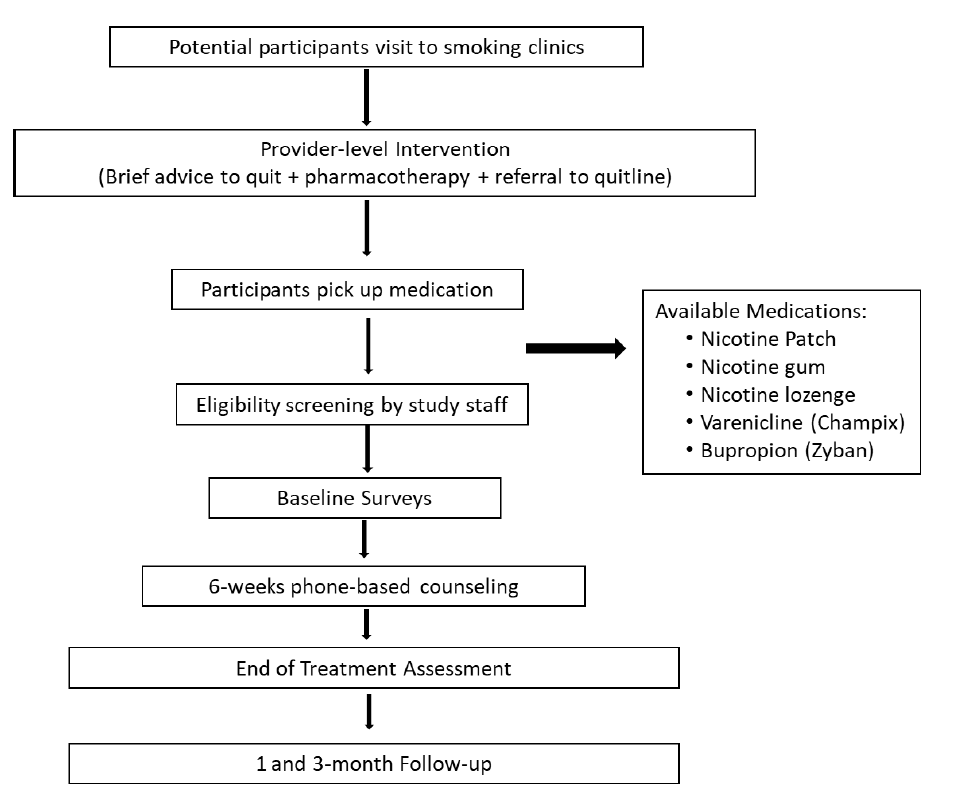
Figure 1. Participant recruitment and study flow. Table 1. Outline of quitline counseling